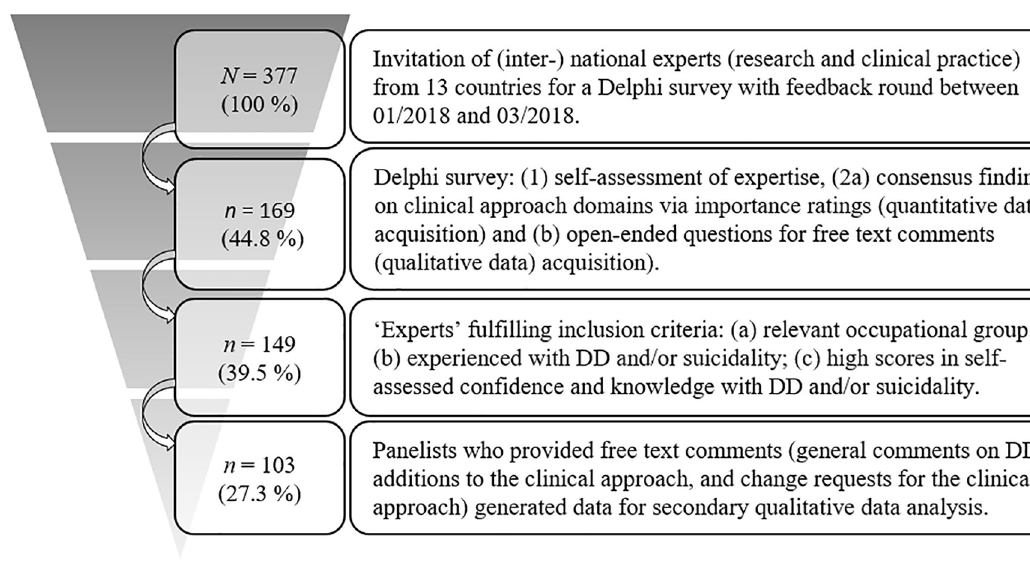
Fig 1. Research sample